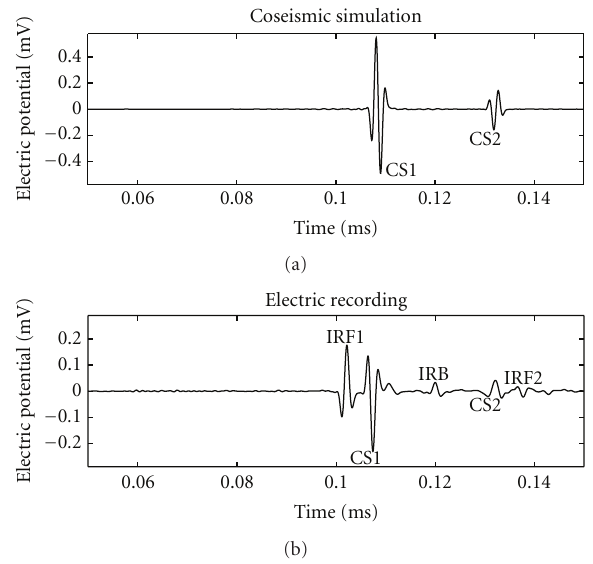
Figure 10: (Modified from [44].) Model of coseismic responses (a) and seismoelectric wave propagation measurements (b). Pulse abbreviations are: interface response (from the) front 1 (IRF1), coseismic response 1 (CS1), interface response (from the) back (IRB), coseismic response 2 (CS2), and interface response (from the) front 2